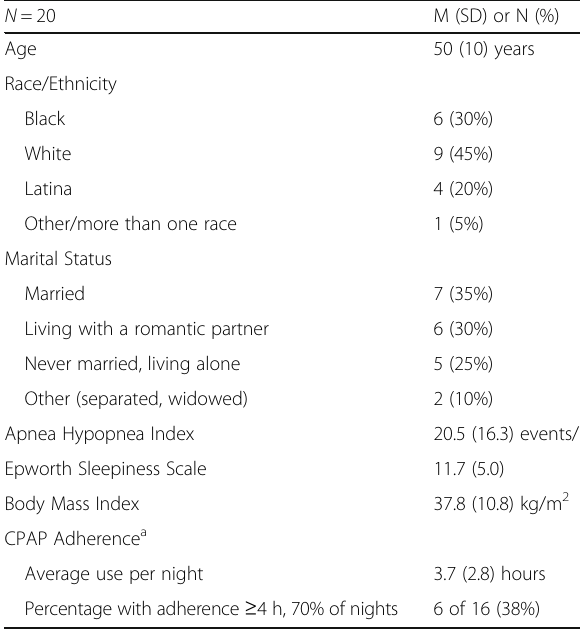
Table 1 Participant Characteristics Table 2 Comparison of key variables for married/partnered